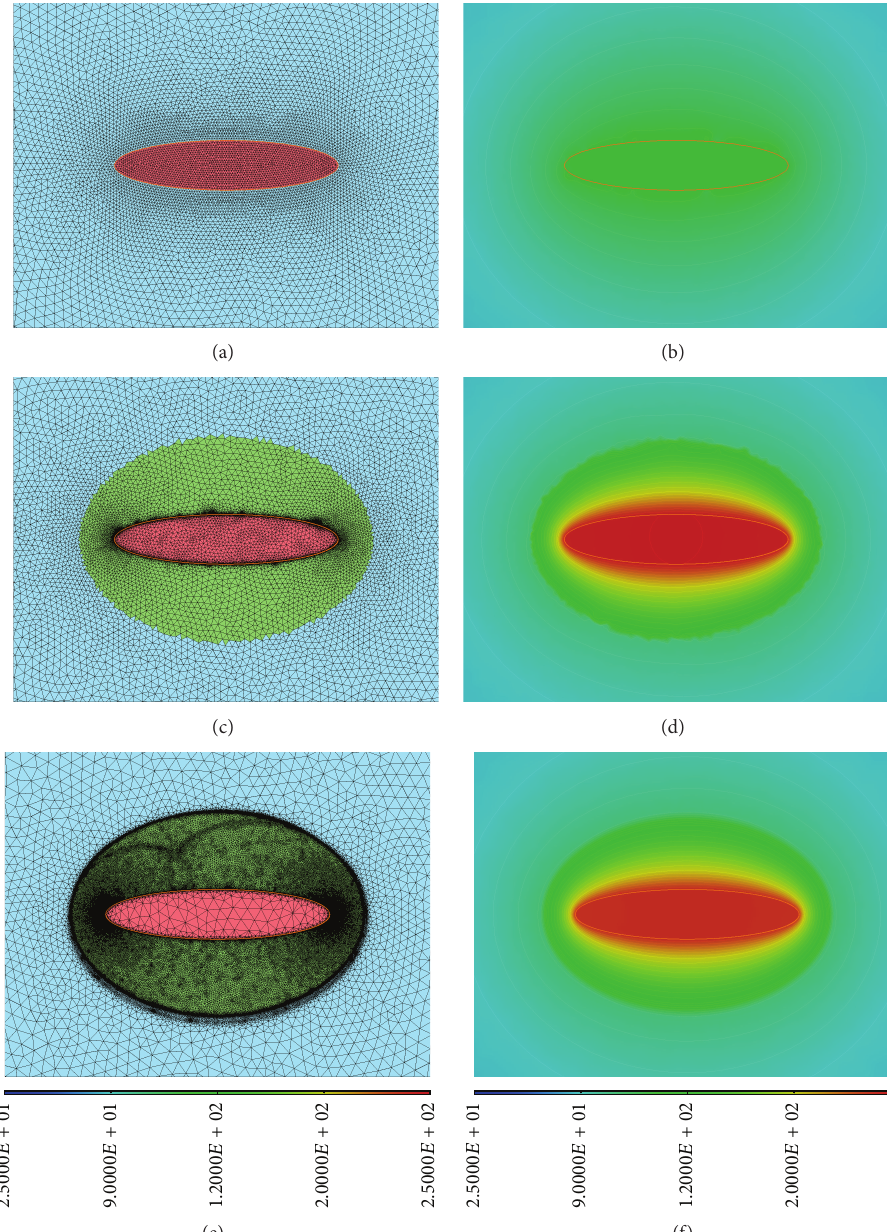
Figure 1: Initial mesh 𝑀 0 (a) and adaptive meshes 𝑀 𝑉 for nanowire illuminated at 𝜆 = 1050